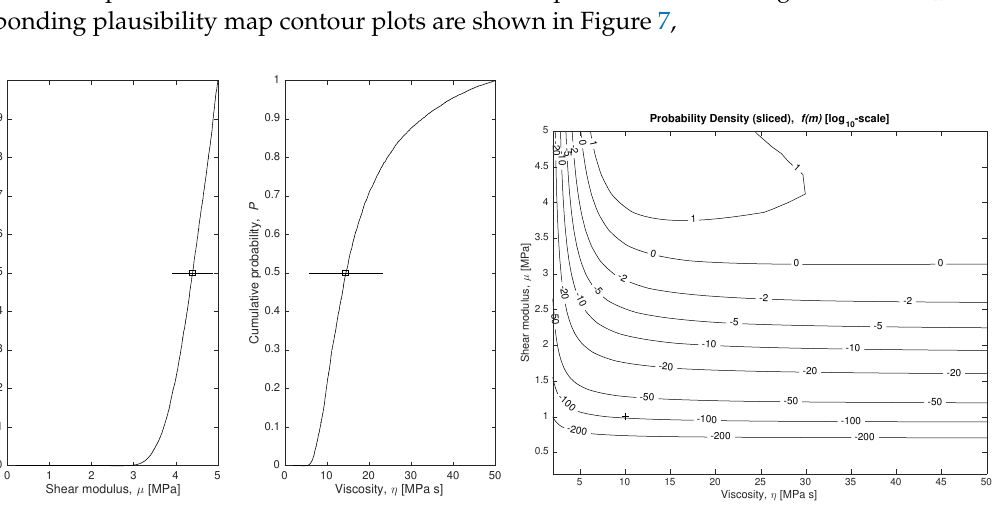
Figure 7. Left: marginal plausibility maps of model parameters using the model H 2 . The expected values ( p = 50% value) are marked, as well as their standard deviation bars. Right: plausibility maps of the model parameters using the model H 2